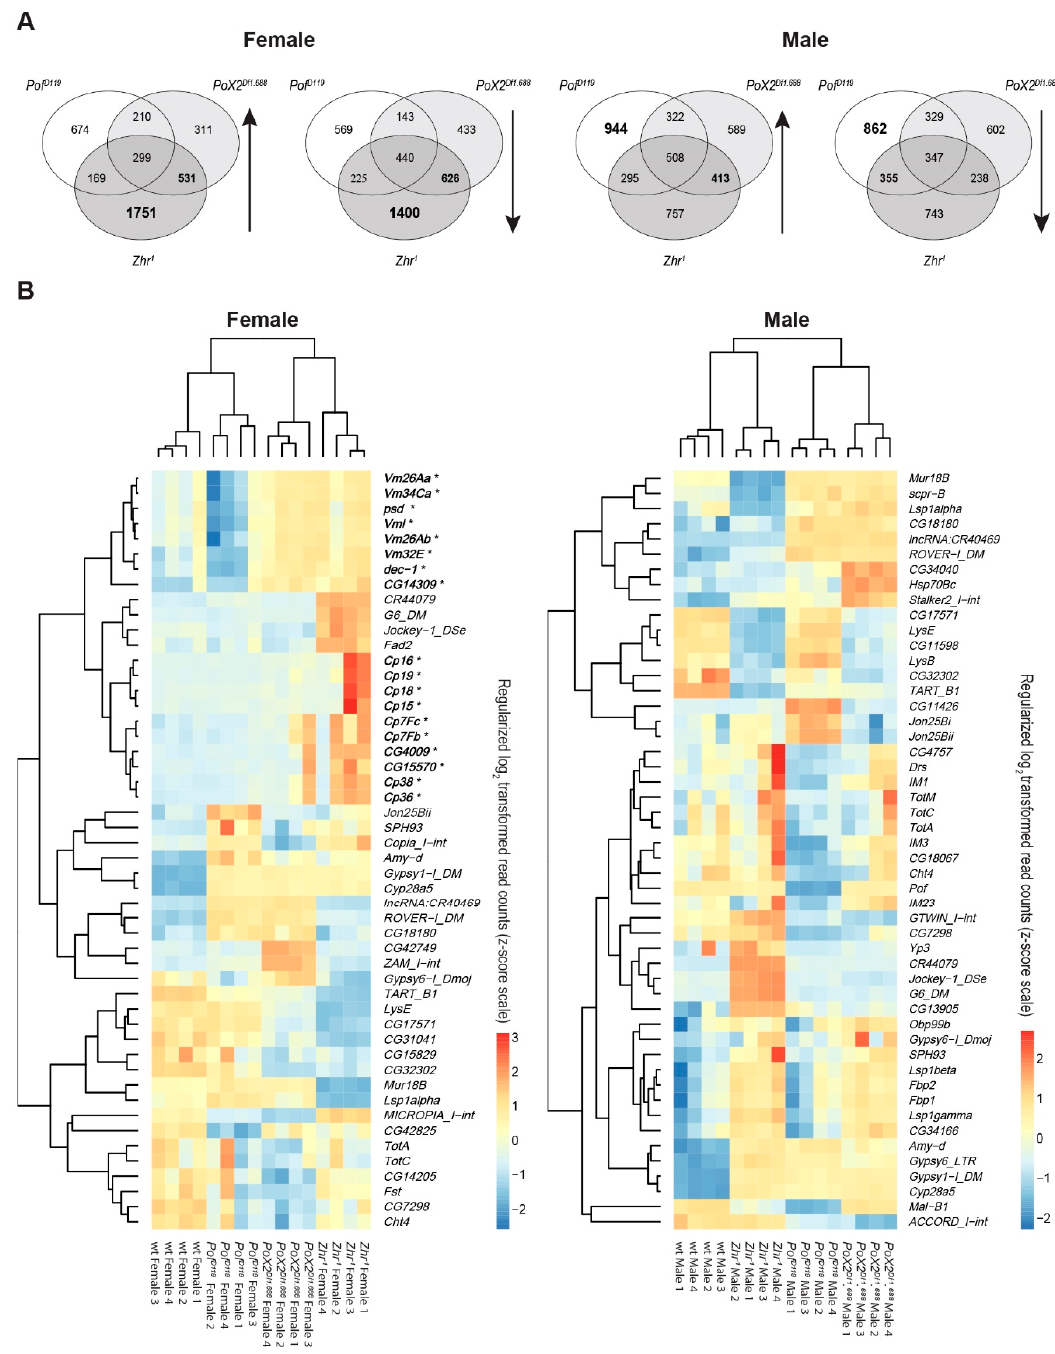
Figure 8. Co-regulated and most variable genes and transposons in the mutants versus wild type. ( A ) Venn diagram of co-regulated genes and transposons in the mutants versus wild type. ( B ) Heatmaps of the most variable genes and transposons in the genotypes (top 50) shows that several upregulated genes in Zhr 1 females are involved in eggshell formation (in bold, indicated by *).